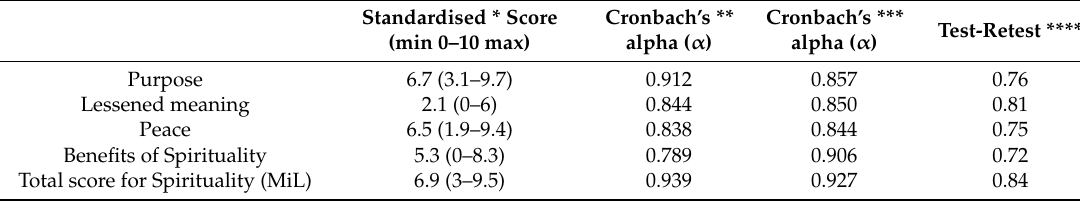
Table 2. Descriptive analysis of the Meaning in Life Scale (MiLS-Sp) † (n =